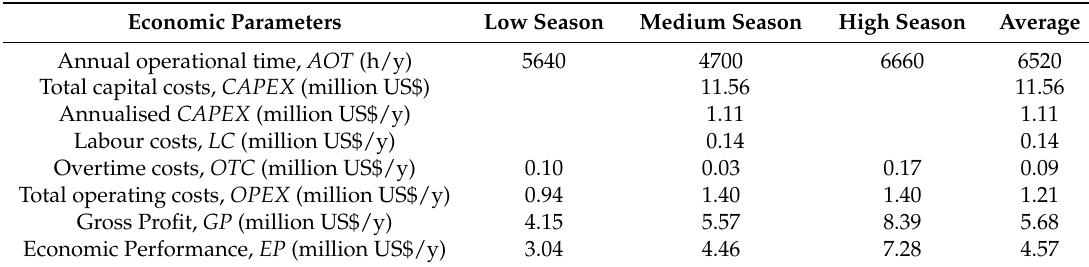
Table 8. Economic parameters for optimised POM design.